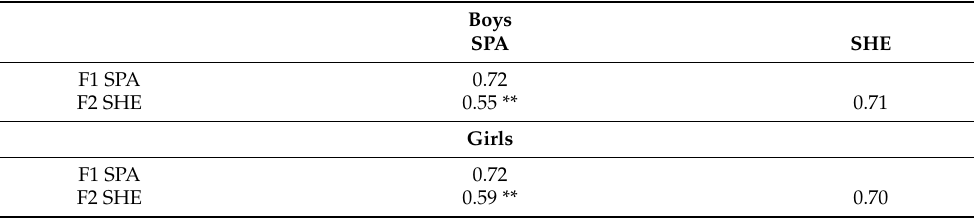
Table A3. Correlation between the factors and average variances.